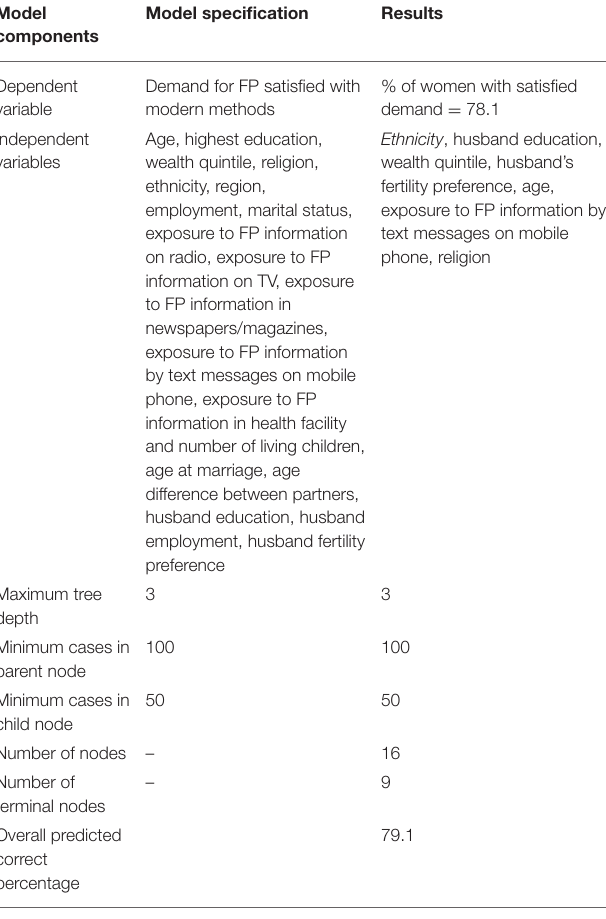
TABLE 5 | Summary information of the specifications used to build the CHAID model for urban women in union. Model